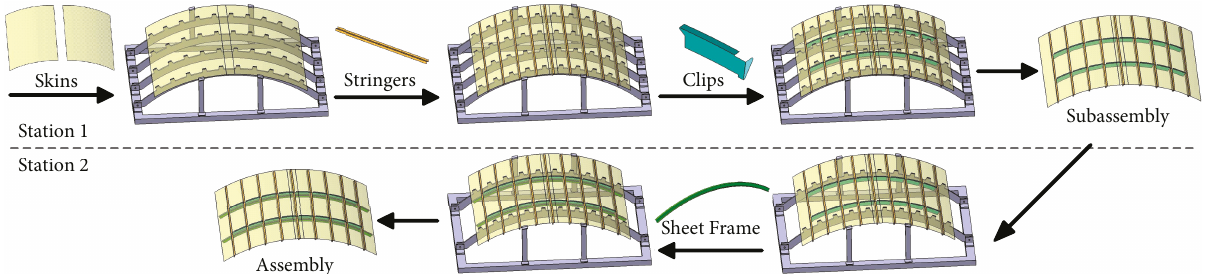
Figure 1: Assembly process of an aircraft panel.